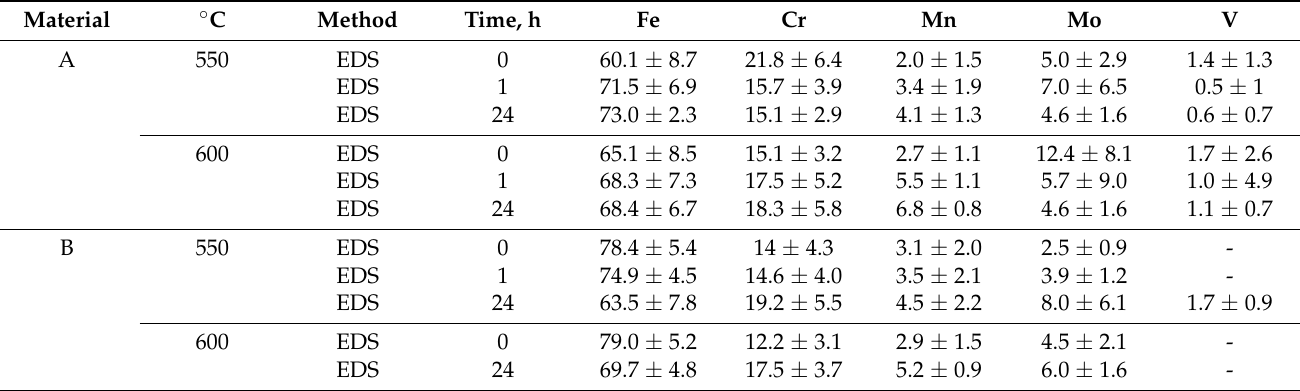
Table 3. At% of metal constituents in cementite carbides.